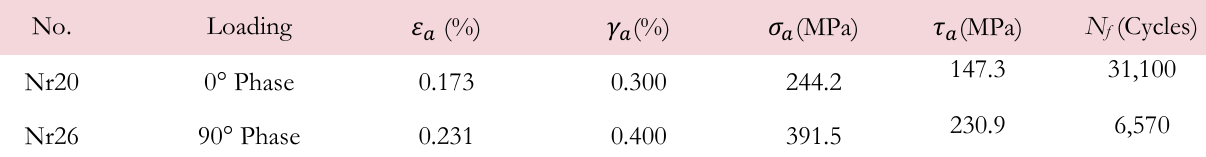
Table 2: Summary of cyclic tests [14].